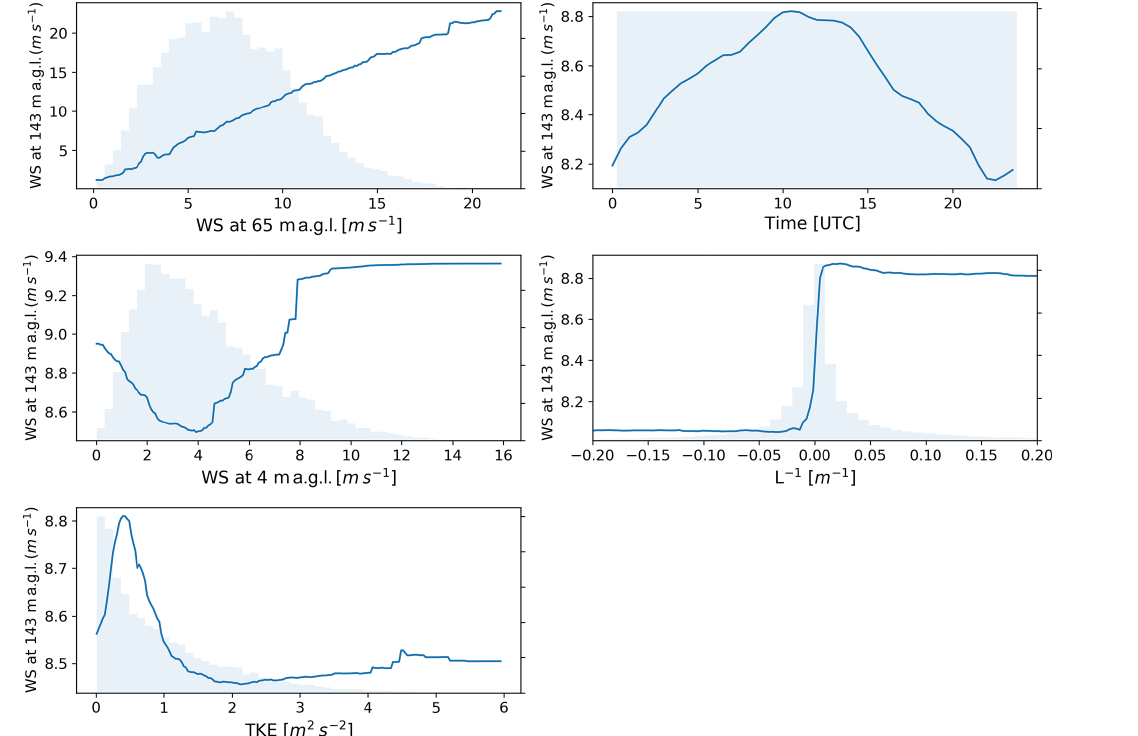
Figure 7. Extrapolated wind speed dependence on individual features for the C1 site. The distribution of each feature is shown in light